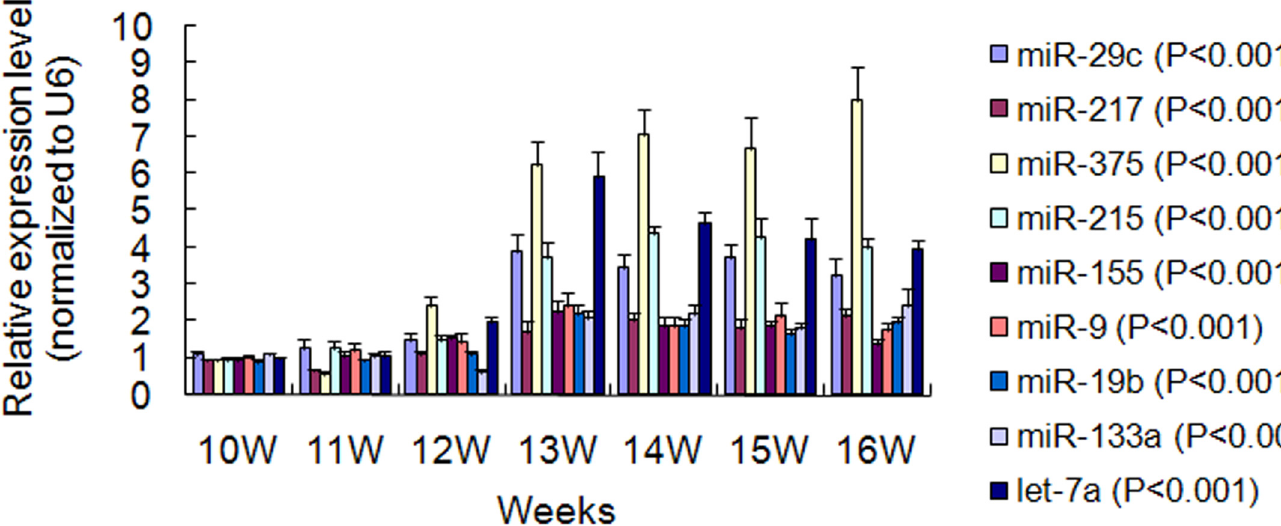
Fig 3. Relative expression changes of 9 candidate serum-miRNAs in different stages. Bars show standard deviations for replicates (n = 6).